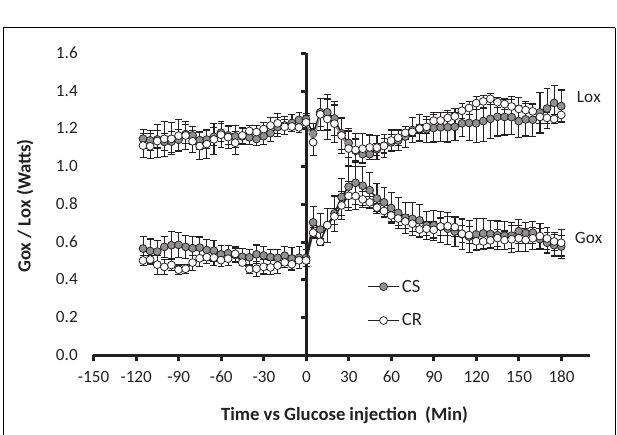
FIGURE 4 | GTT-induced changes in glucose oxidation (Gox) and lipid oxidation (Lox) . Glucose 1.5g/kg (solution 250mg/ml) was injected i.p. at t0 (see Materials and Methods). Note in comparison to Figure 1 , the 10-fold difference on the y -axis, the twofold difference on the time axis, and the fact that the MTT affected both Gox and Lox while the GTT affected Gox much more than Lox.